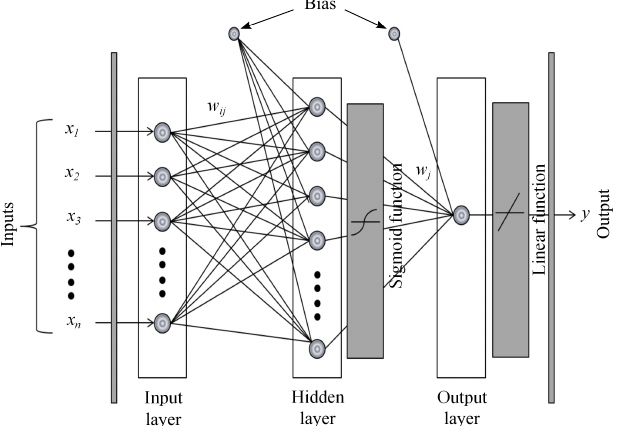
Figure 4. Example of a single hidden layer neural network.